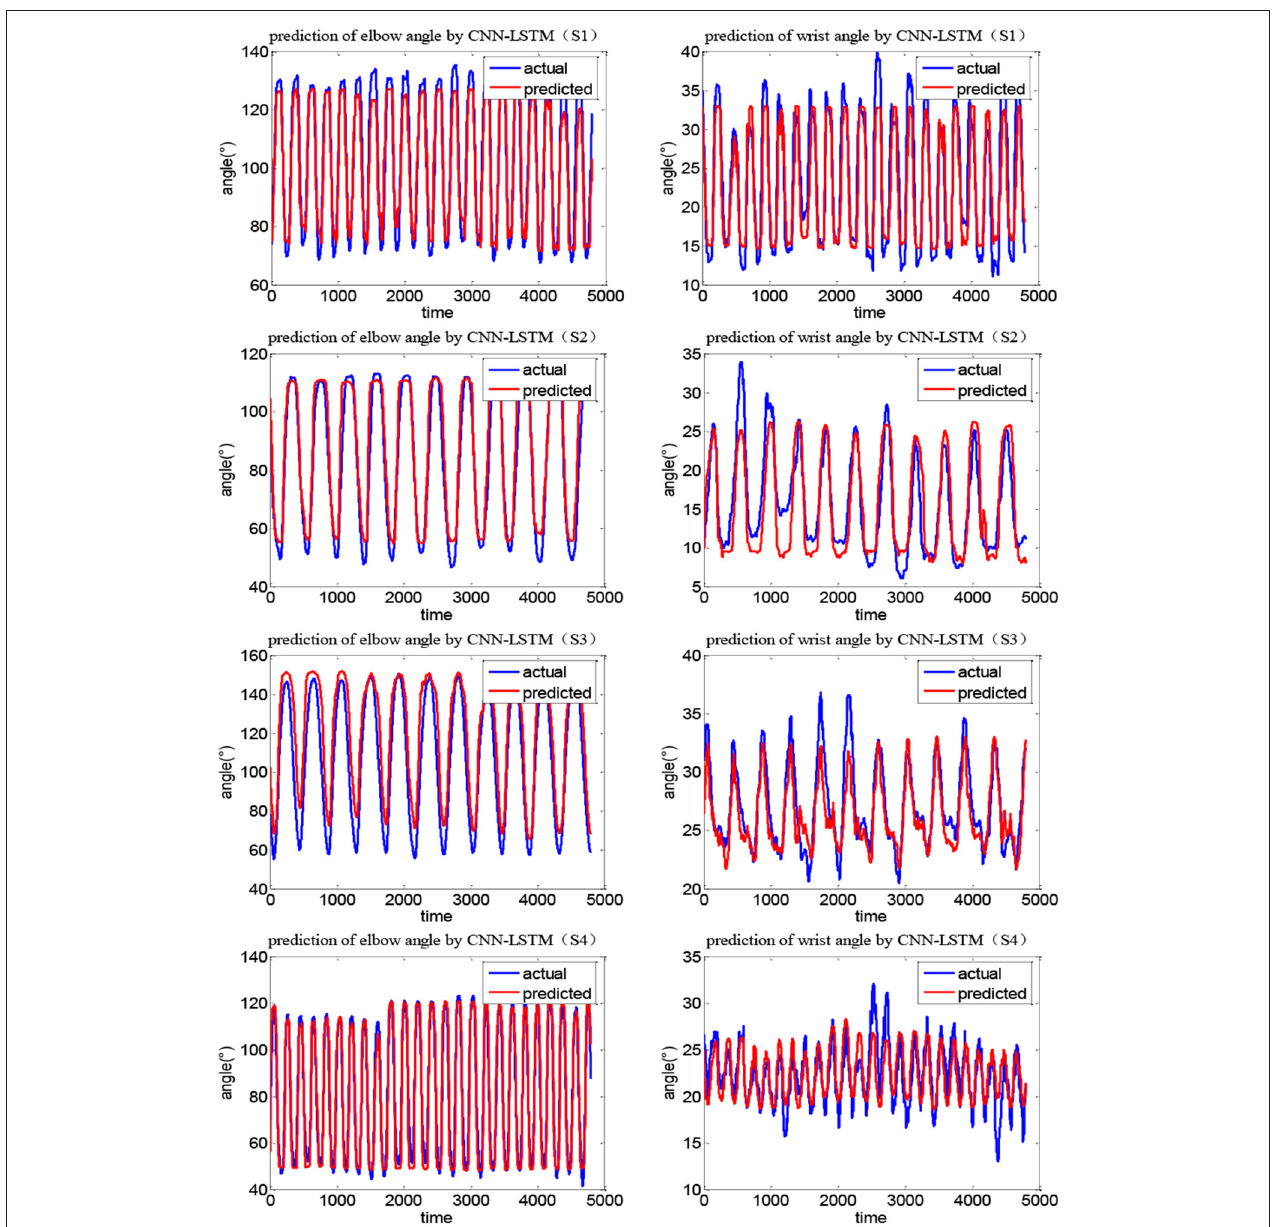
FIGURE 12 | Joint angle prediction results of four subjects (Task